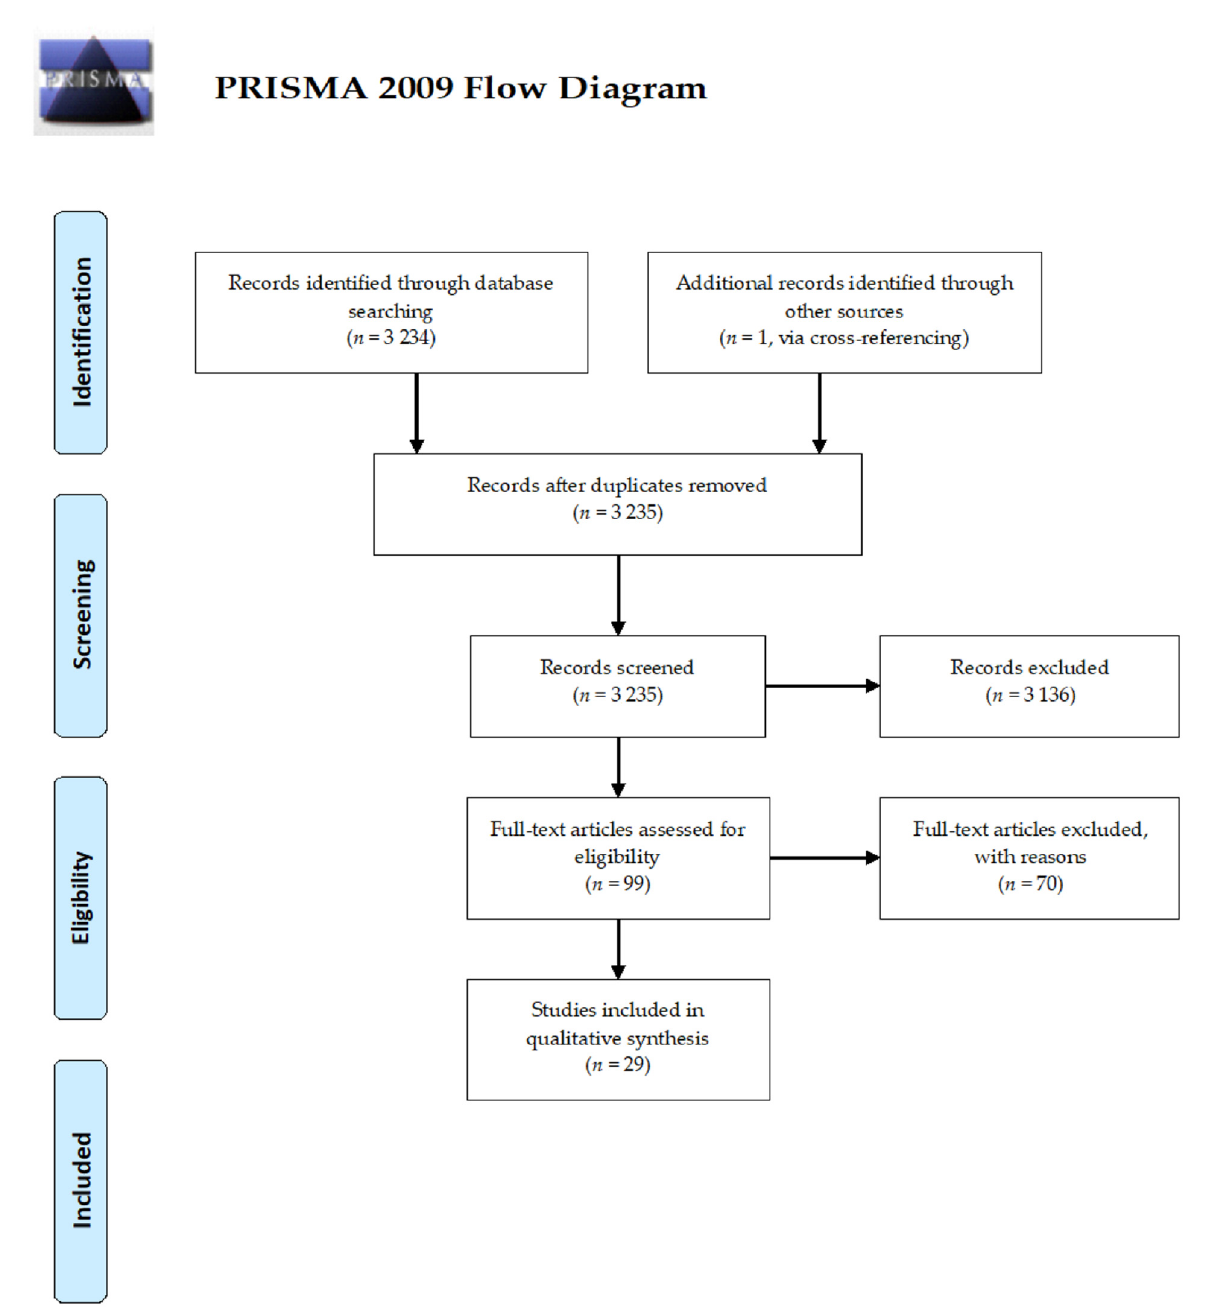
Figure 1. Flowchart showing the retrieval and inclusion processes strategy adopted in the present integrative review.